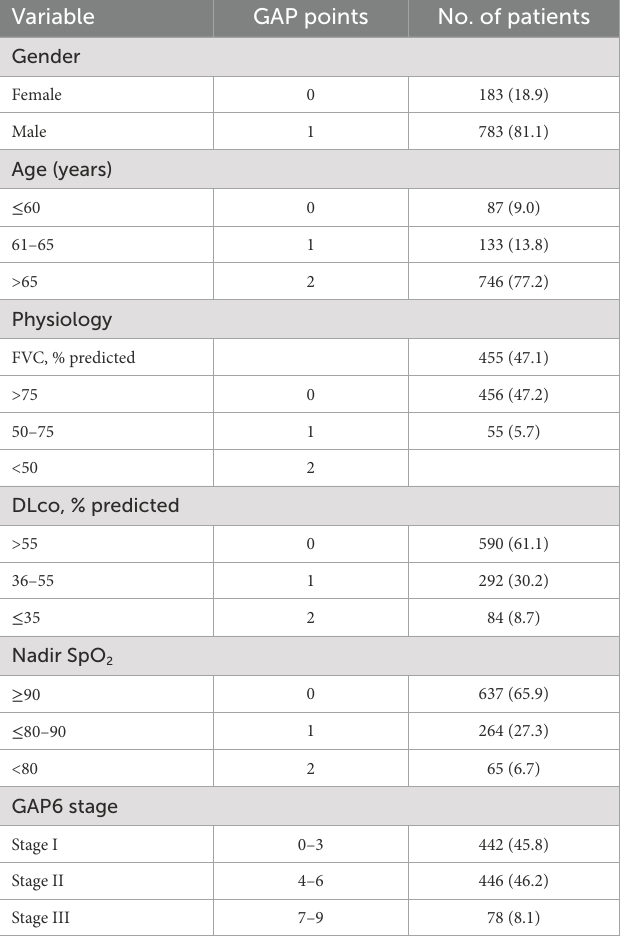
TABLE 5 GAP6 index and number (%) of